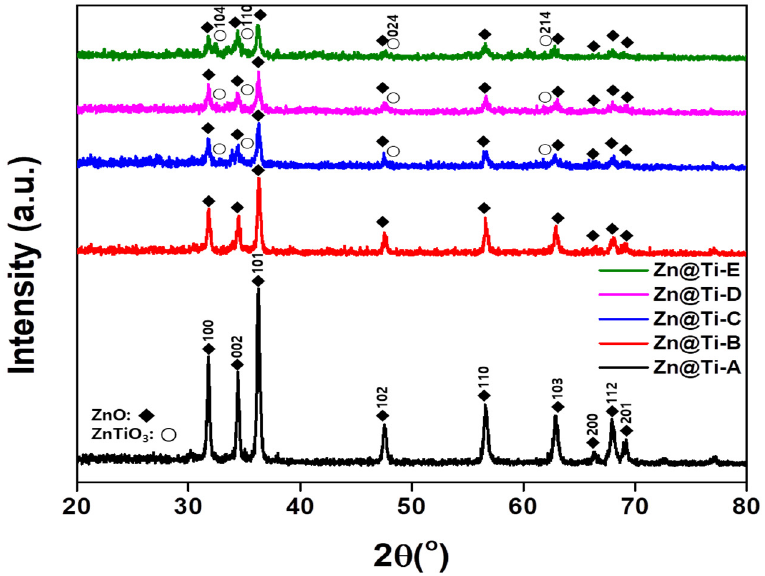
Figure 1. SEM images of plasma-synthesized composites of zinc and titanium oxide; the SEM im- ages of ( a – e ) are taken from the samples of Zn@Ti-A, Zn@Ti-B, Zn@Ti-C, Zn@Ti-D, and Zn@Ti-E, respectively. The graphs of ( f – j ) are EDS of ( a – e ), respectively.